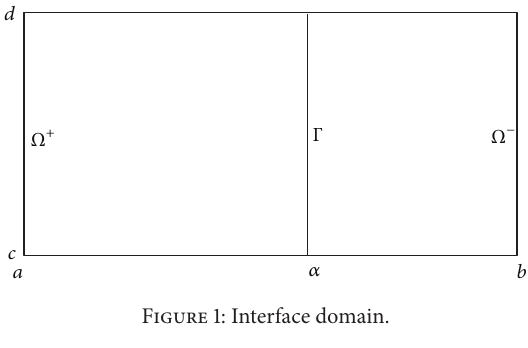
Figure 1: Interface domain.